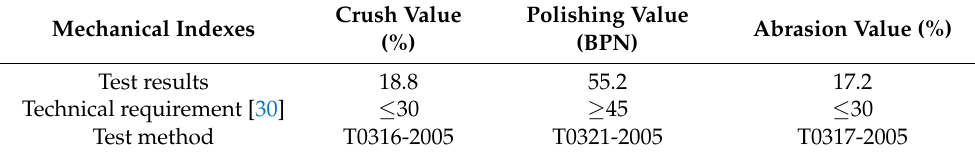
Table 3. The mechanical indexes of basalt.